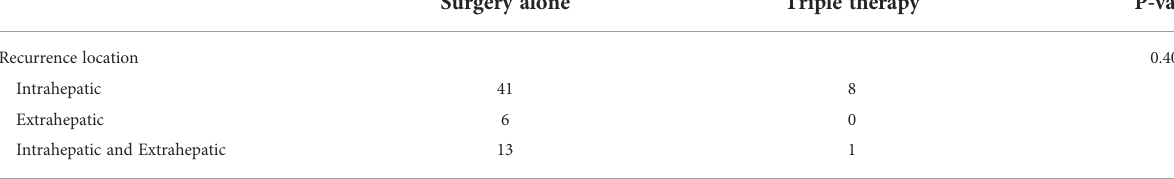
TABLE 5 Recurrence location after